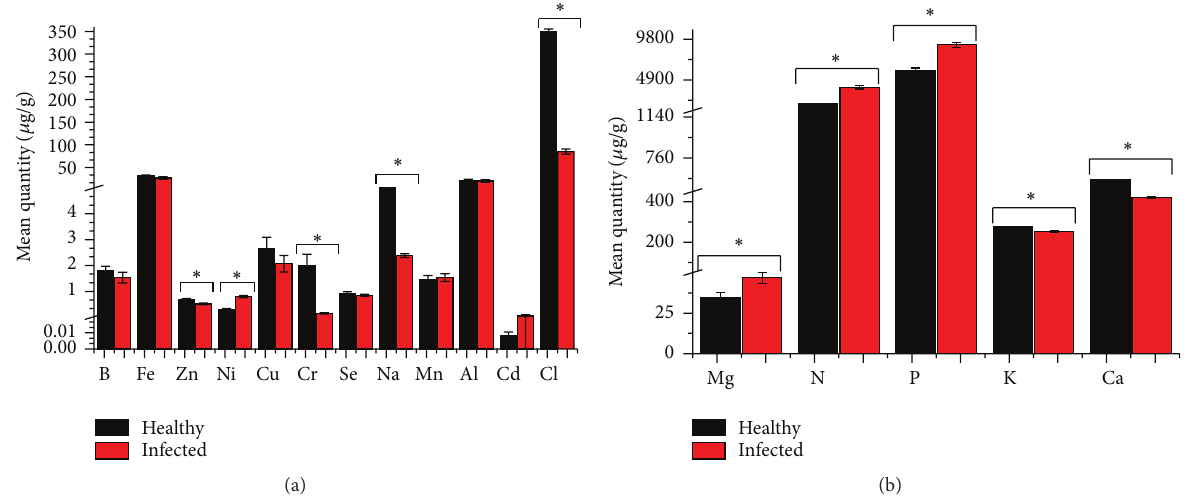
Figure 3: Quantification of mineral contents ( 𝜇 g/g) in healthy and infected stem bark of mango suffering from quick decline disease. Each bar represents mean ± SD contents of the specific mineral as indicated. ∗ indicates that there was a significant difference between healthy and infected sample at 95%